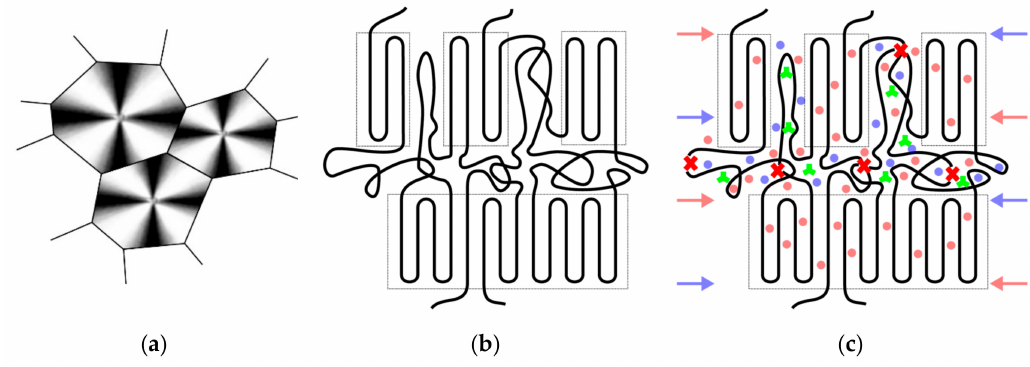
Figure 8. Schematic of key features of the inner material structure of semi-crystalline polymers and the interaction with environmental conditions, ( a ) spherulite structure, ( b ) stacked lamellar structure with inter-spherulitic and inter-lamellar amorphous domains with tie molecules and entanglements, and ( c ) stacked lamellar structure with stabilizers in the amorphous regions (green stars) and interaction with environmental conditions (temperature: red arrows and dots, liquid: blue arrows and dots) leading to aging-induced chain scission (red crosses) in the amorphous